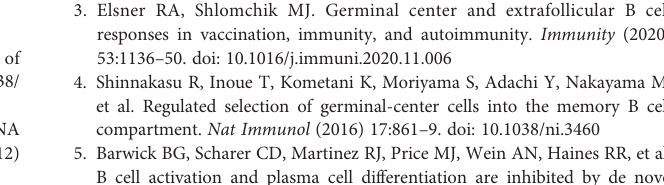
Supplementary Table 1 | Antibodies and reagents. Supplementary Table 2 | Oligonucleotide